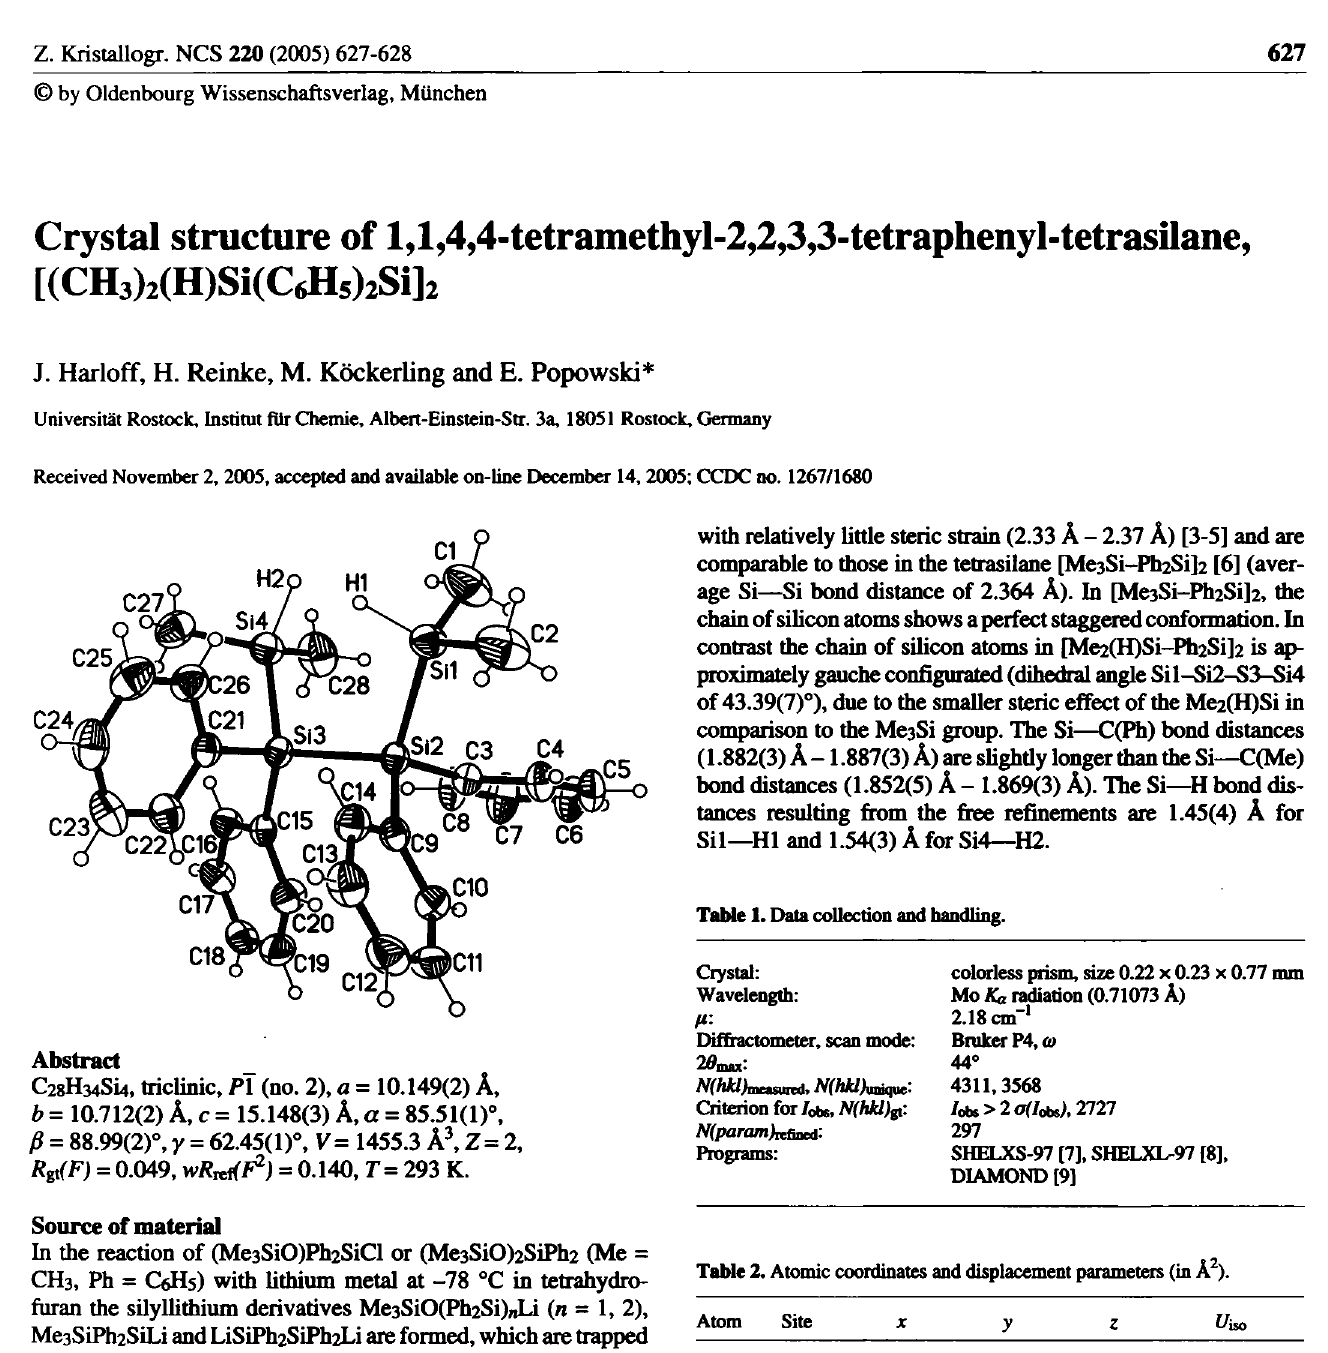
Table 2. Atomic coordinates and displacement parameters (in A 2